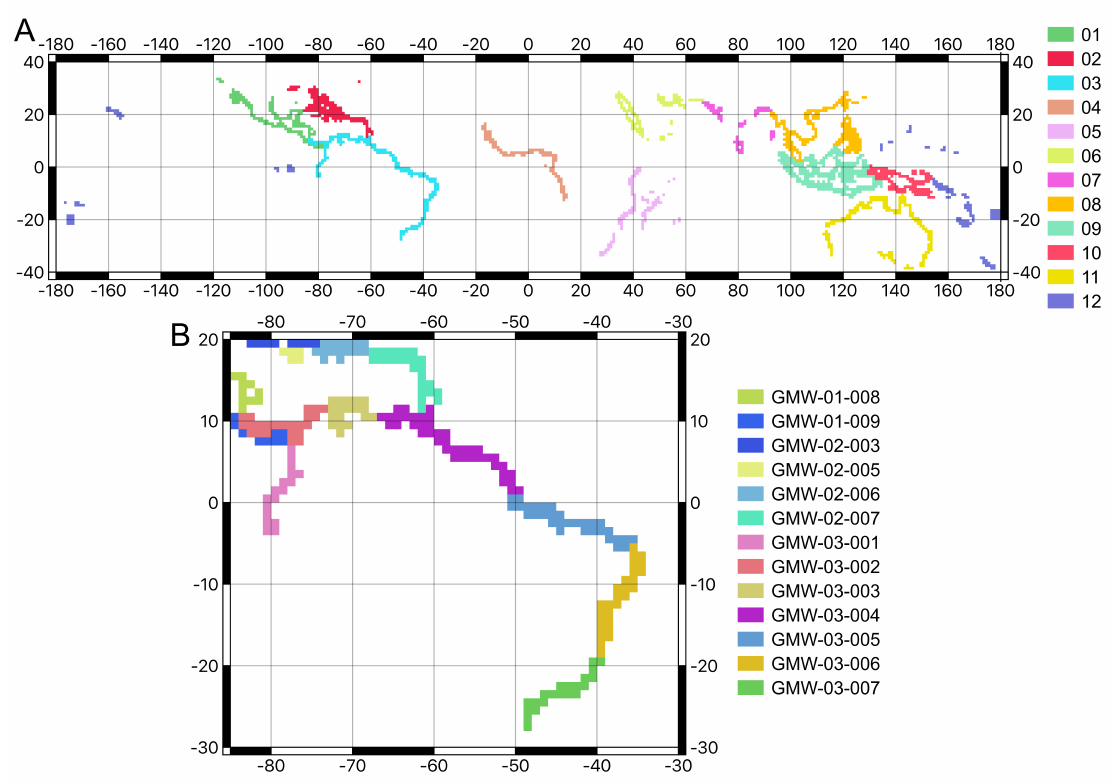
Figure 2. GMW project regions: ( A ) the 12 top level regions; and ( B ) an example of the individual projects for the South American